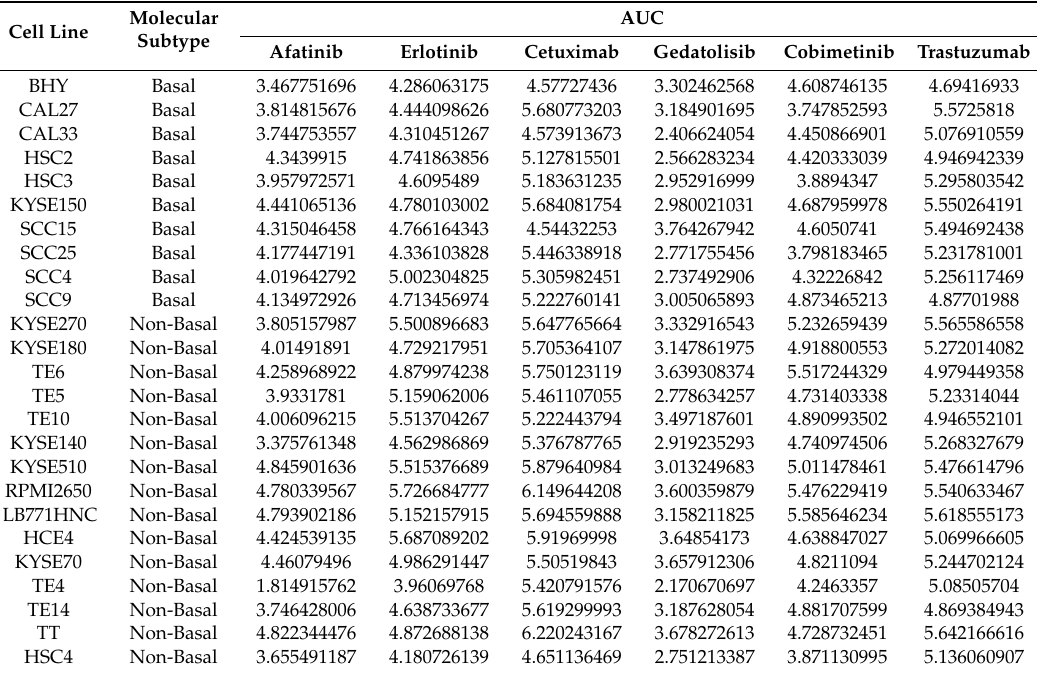
Table 1. Analysis of the response of basal-like and non-basal like HNSCC cell lines to treatment with Afatinib, Erlotinib, Cetuximab, Gedatolisib, Cobimetinib, and Trastuzumab. Cell line names and subgroup (basal versus non-basal), drug names, and AUC are